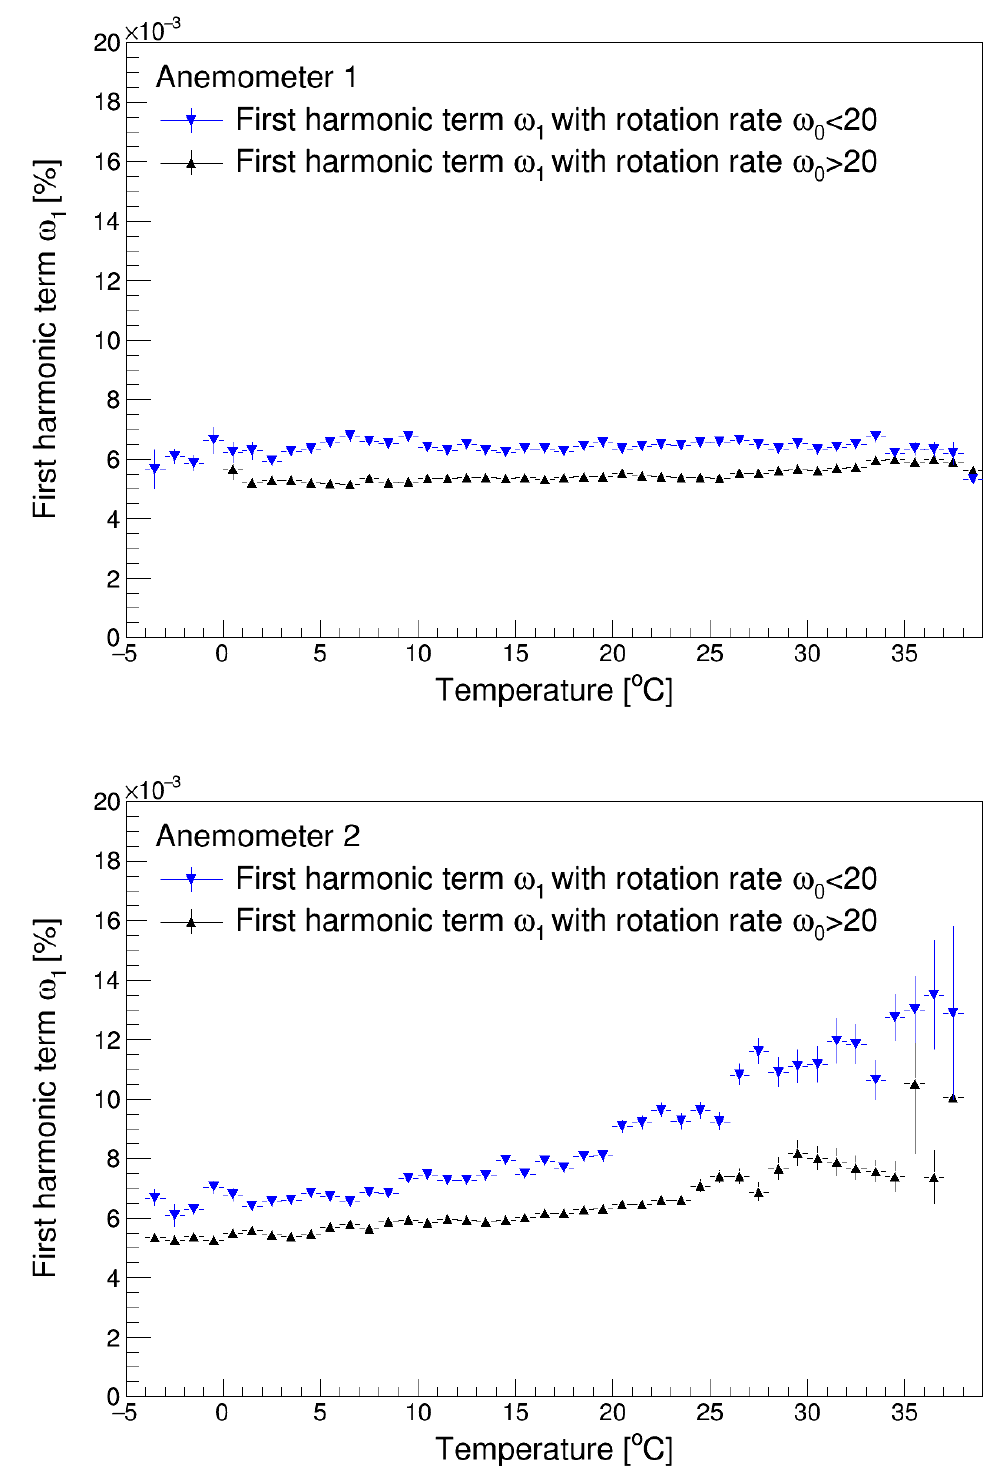
Figure 7. First harmonic terms of Anemometer 1 ( top ) and Anemometer 2 ( bottom ) as a function of temperature.